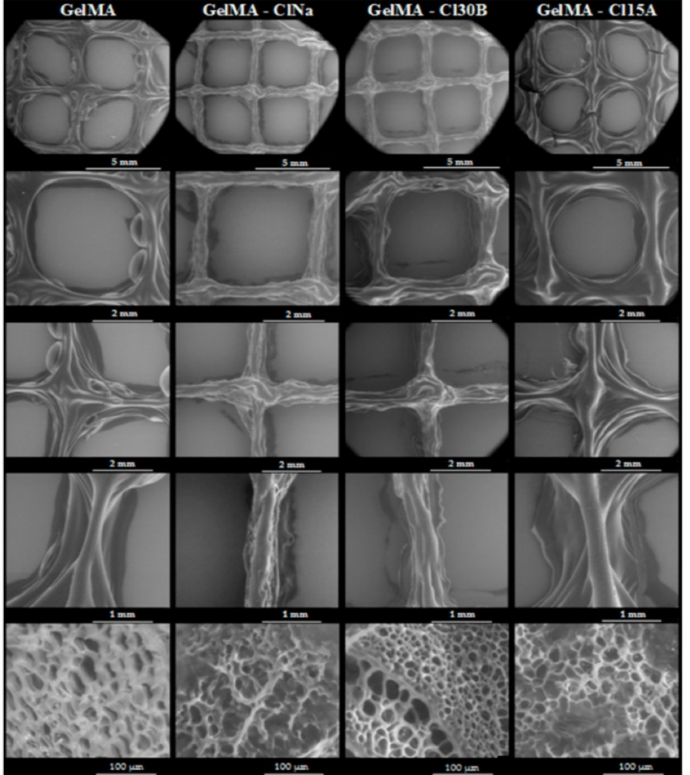
Figure 17. SEM microphotographs of GelMA and different Cloisite ®® formulations. The pore sizes and shapes vary with the type of Cloisite ®® used. Magnifications from top to botton: × 25, × 50, × 50, × 100 and × 1000. Reproduced with permission from [105], MDPI,